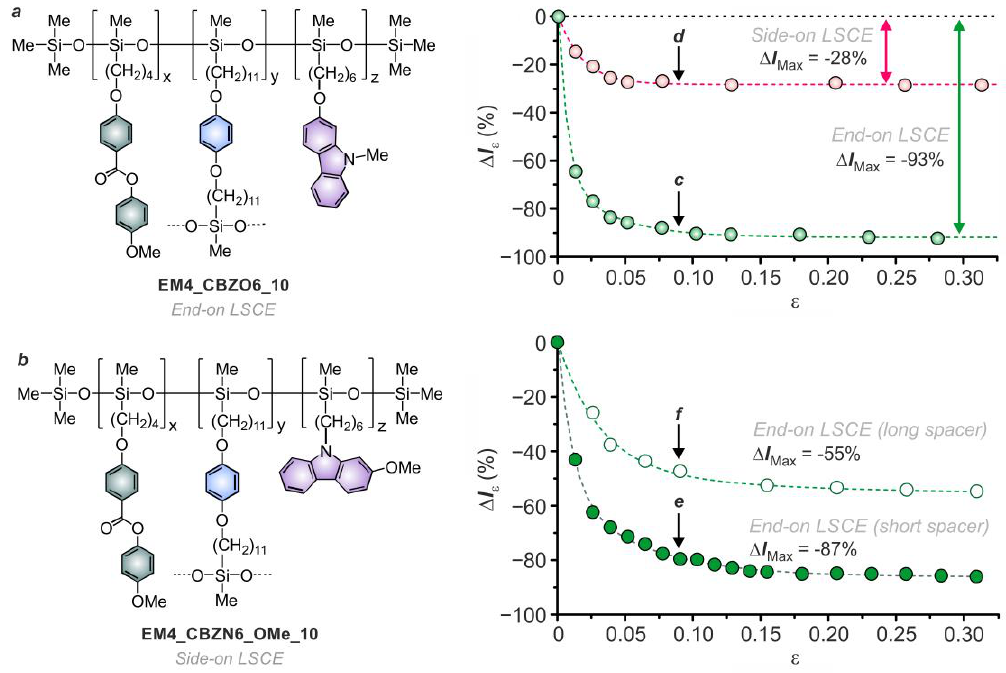
Figure 5. Chemical composition ( a , b ) and mechanofluorescent response ( c , d ) for the end-on ( a , c ) and side-on ( b , d ) LSCEs EM4_CBZO6_10 and EM4_CBZN6_OMe_10. Mechanofluorescent response for end-on elastomers with a different flexible spacer length ( e , f ) [58]. (Copyright from ACS Applied Polymer Materials 2019).